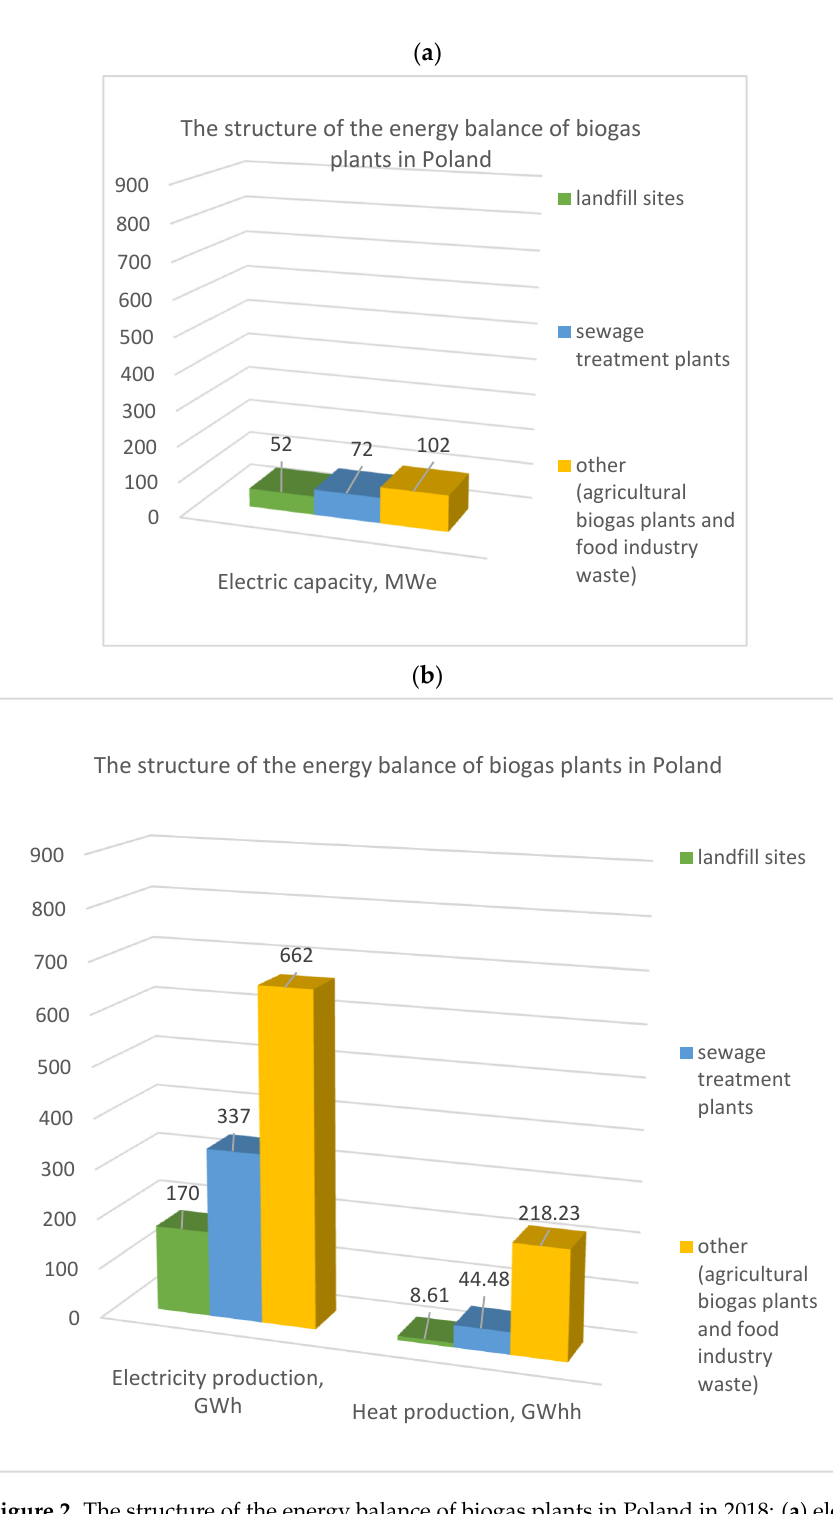
Figure 2. The structure of the energy balance of biogas plants in Poland in 2018: ( a ) electric capacity of biogas-burning facilities (MW e ); ( b ) electricity production (GWh) and heat production from biogas-burning (GW h h).